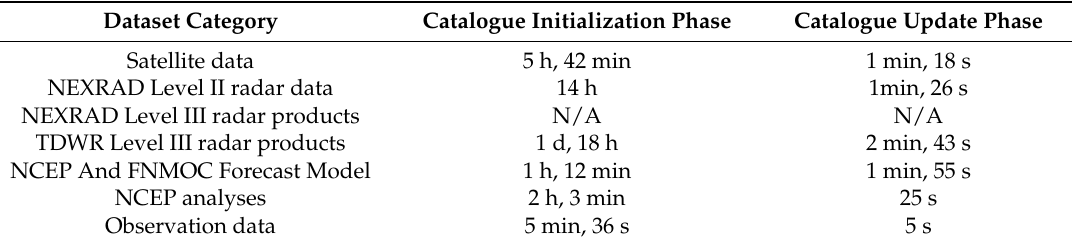
Table 7. Actual elapsed times for catalogue initialization and update